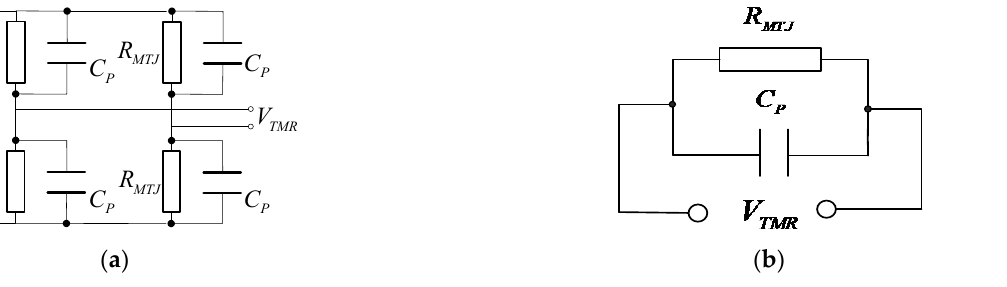
Figure 3. TMR sensing characteristics. ( a ) Resistance of magnetoresistance versus magnetic field, ( b ) Wheatstone bridge structure of the TMR sensor.